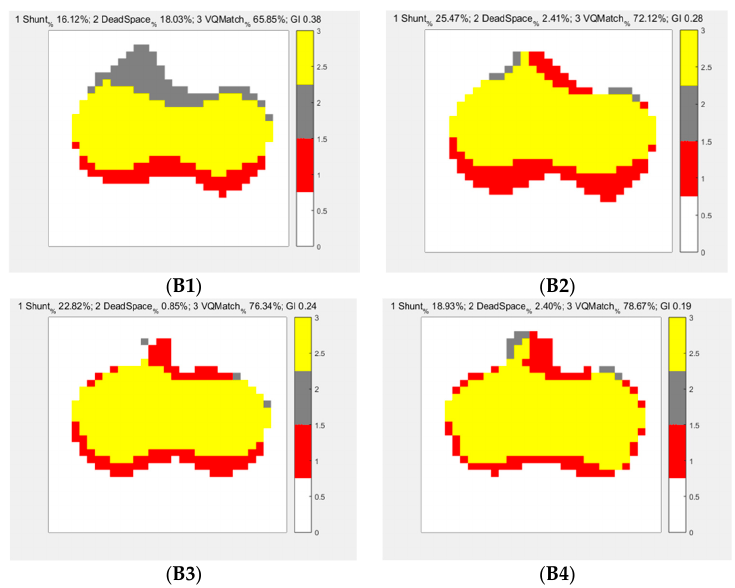
Figure 2. EIT images under different VTs and PEEPs. ( A ) High VT intervention (VT = 15 mL/kg), and ( B ) low VT intervention (VT = 6 mL/kg). The PEEP changes are shown from left to right of 0, 5, 10, and 20 cmH 2 O. During high VT with increasing PEEP, the shunt situation gradually improved, and the V/Q tended to be close to 0.8. However, the greater the PEEP was, the higher the peak airway pressure, and eventually, the right lung was not ventilated, which caused overshunting (30.01 ± 0.69%). During low VT with increasing PEEP, the dead space decreased, the shunt continued to decrease, and V/Q also tended to be close to 0.8. When PEEP = 20 cmH 2 O, the V/Q improvement of the low tidal volume group was more significant than that of the high tidal volume group (76.57 ± 1.25% vs. 65.12 ± 1.97%, p < 0.001). Please refer to the illustration on the right for different colors. Red stands for shunt, black stands for dead space, and yellow stands for VQ match.